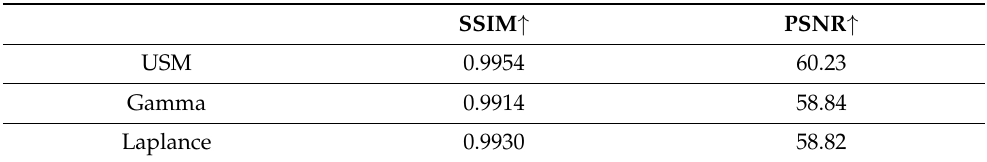
Table 1. Quantitative results of different edge enhancement methods in terms of SSIM/PSNR (higher is better).